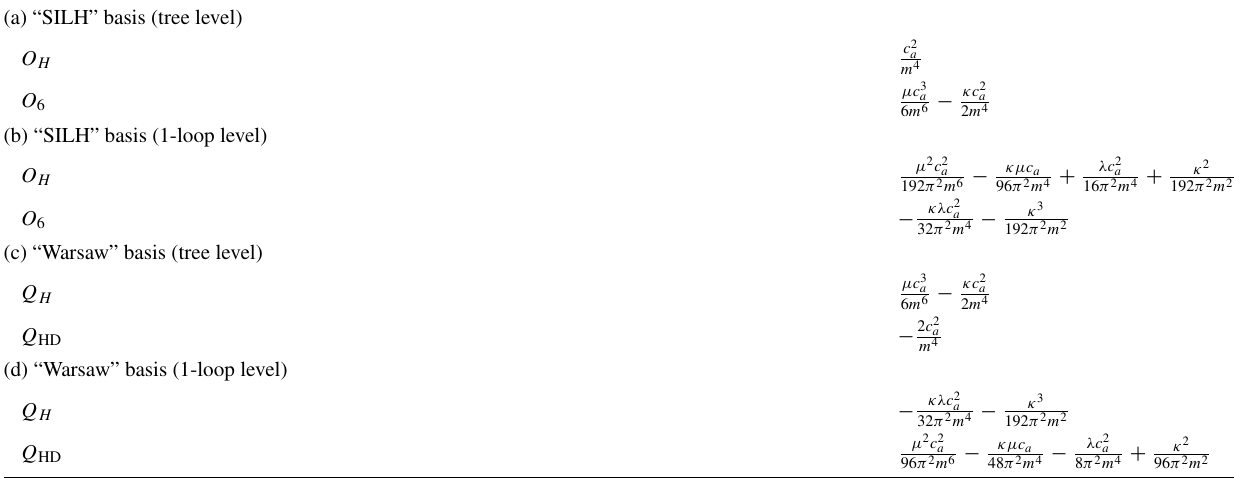
been considered. Here we have highlighted the extra terms obtained in our calculation in the MS scheme in ‘Red’ color. We have further cross-checked these results in the other scheme, adopted in Ref. [19], explicitly. For results in “Warsaw" basis, no such comparison has